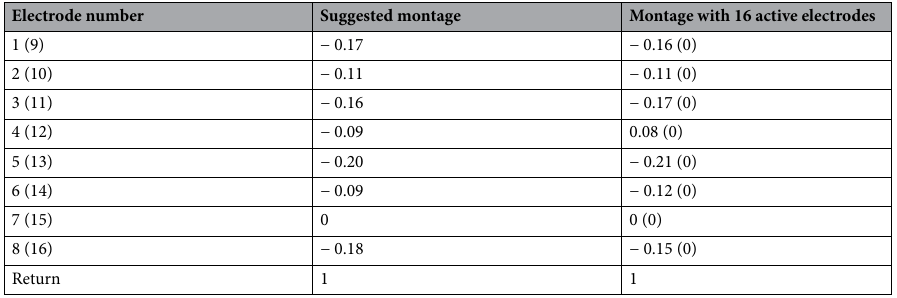
Table 3. Amplitudes of optimized injection currents for the suggested montage with 8 active electrodes and the montage with 16 active electrodes. (Unit: mA). In case of the montage with 16 active electrodes, the injection current amplitudes for the electrode numbers 9 to 16 are given in the